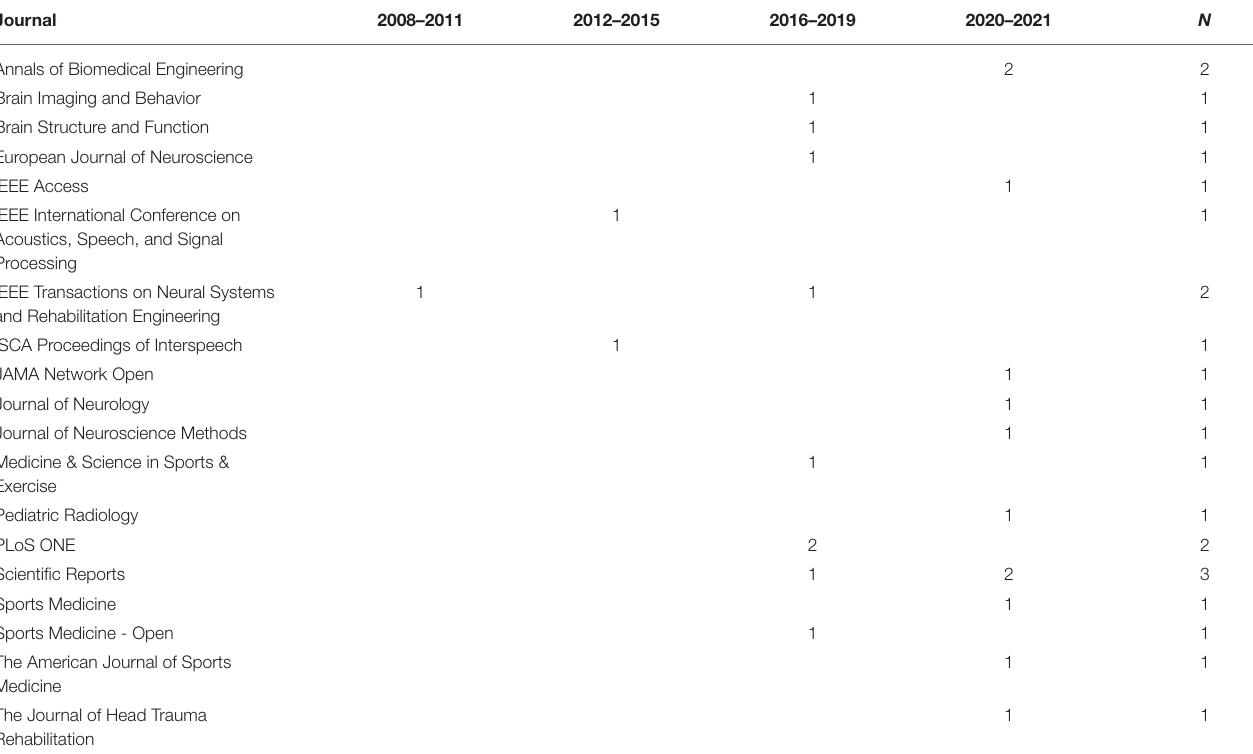
TABLE 3 | Reviewed literature by journal and year of